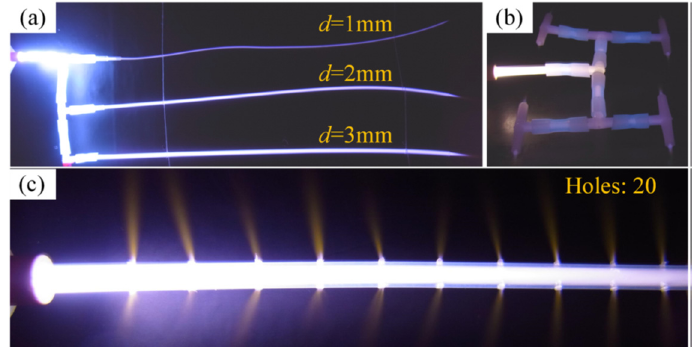
Figure 13. ( a ) Non-thermal plasma jets along flexible tubes branched with 3 bifurcations with different diameter values, d . ( b ) System with several bifurcations. ( c ) Plasma jet brush mode with 20 holes. Reprinted/adapted with permission from Ref. [55]. Copyright 2018, Authors.